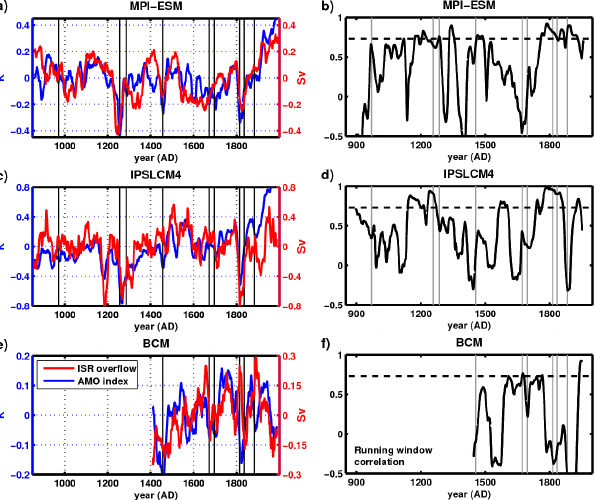
Figure 2. Left panels: anomalous simulated AMO index (blue line) in MPI-ESM (a) , IPSLCM4 (c) and BCM (e) compared to the AMO reconstruction (grey line) from Gray et al. (2004). Right panels: anomalous simulated overflow transport across the ISR (red line) in MPI-ESM (b) , IPSLCM4 (d) and BCM (f) compared to the recon- structed Iceland–Scotland overflow strength (grey line) from Mjell et al. (2015). All time series are normalised by the respective stan- dard deviations. Simulated time series are annual values with a 21- year running mean filter applied. The vertical lines indicate years with major volcanic eruptions (following Zanchettin et al., 2012).